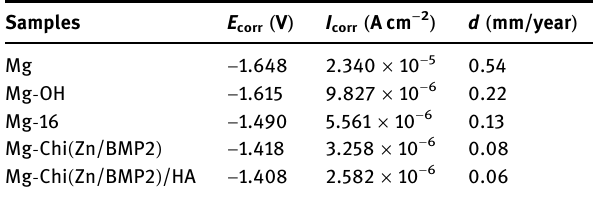
Table 2: Corrosion potential, corrosion current density, and annual corrosion depth of the di ff erent